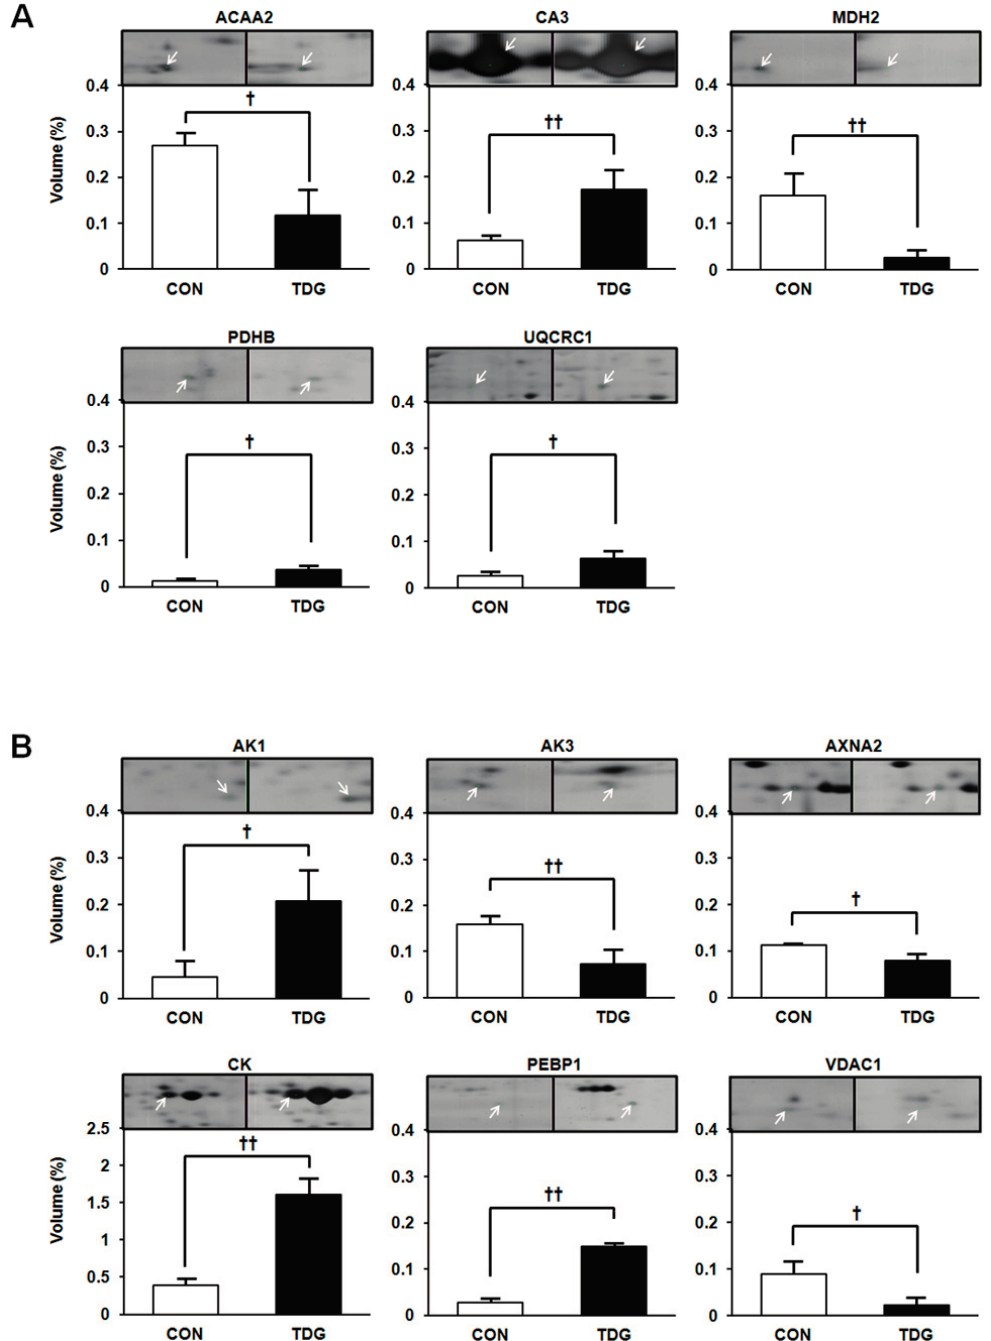
Figure 4. WAT proteins showing differential regulation between control and TDG-treated groups. Panel ( A ) represents proteins involved in the tricarboxylic acid (TCA) cycle; while panel ( B ) represents the signal transduction and cytoskeletal proteins. Data are presented as the mean ± SD of volume density (%) of altered proteins in pooled samples from six rats in each group. Statistical significance between the control and TDG-treated groups was estimated by Student’s t -test, where p -values are † p < 0.05 and †† p < 0.01. Full names are presented in Table 1 and abbreviation